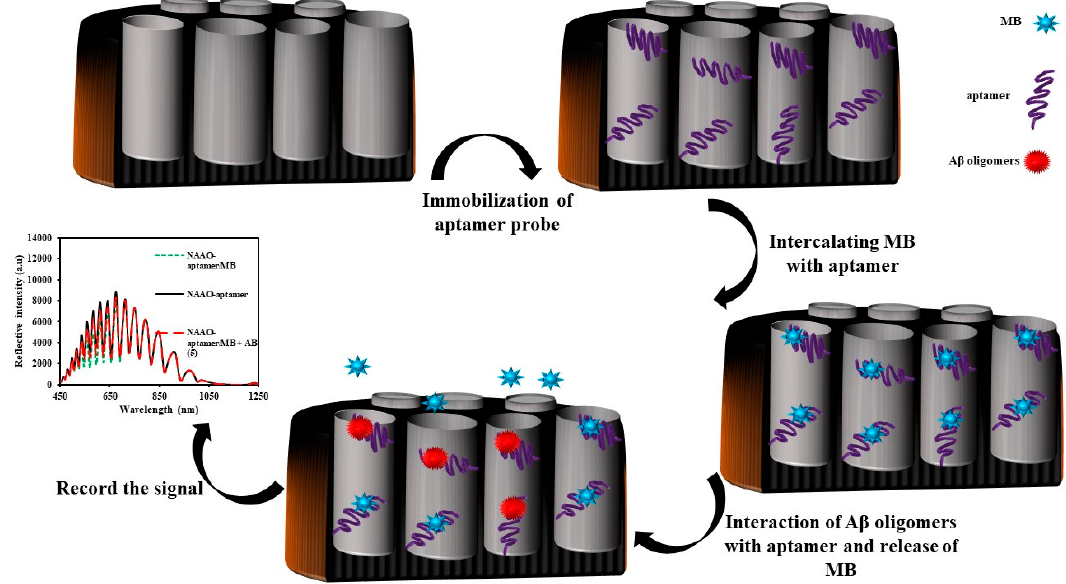
Figure 7. Schematic representation of the fabrication of the NAA-aptamer/MB for the determination of A β oligomers using IRS.